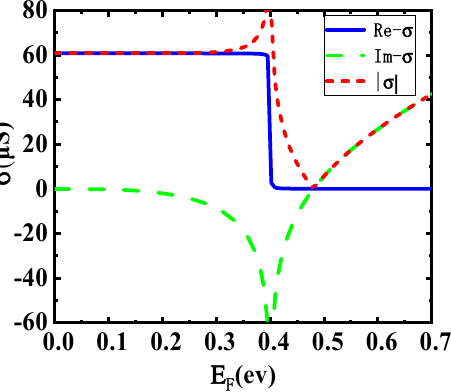
Figure 2. Dependence of graphene conductivity on the Fermi level in 1550 nm incident wavelength.